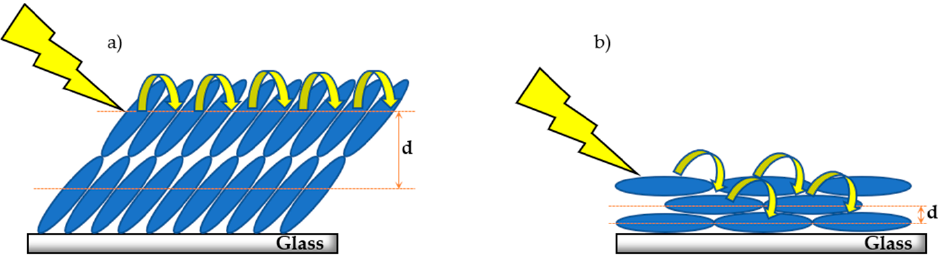
Figure 5. Proposed dominant molecular domain arrangement and exciton diffusion pathway in ( a ) octyl derivative—ZnTCO 4 PP and ( b ) 2-ethylhexyl derivative—ZnTCEH 4 PP of metalloporphyrin thin films.